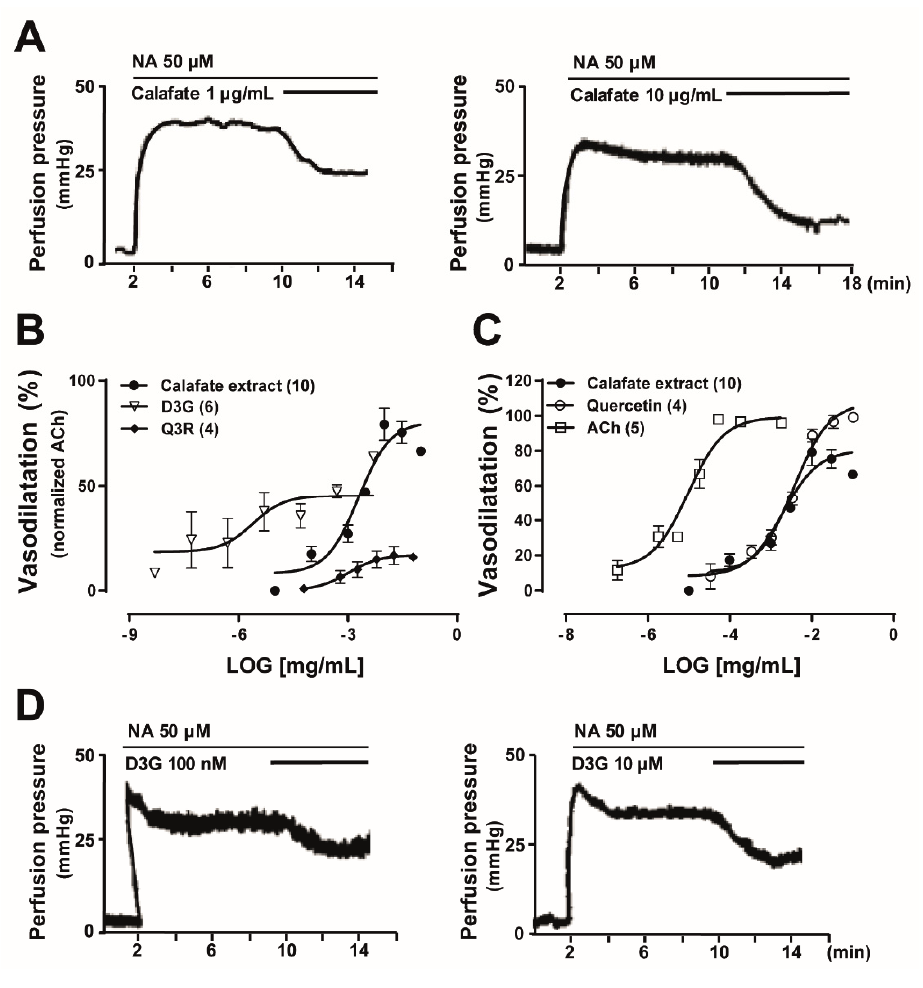
Figure 2. Concentration-dependent vasodilatation induced by Calafate berry extracts and the mimetic action of delphinidin-3-glucoside, quercetin, quercetin-3-rutinoside or acetylcholine in the rat arterial mesenteric bed. ( A ) Representative tracings of the hydroalcoholic extract-induced vasodilatation elicited by perfusion with 1 or 10 µg/mL; the extract was dissolved in distilled water and diluted in perfusion buffer. ( B ) The normalized 1 µM ACh concentration-dependent vasodilatation curves of the hydroalcoholic extract (solid circles) were compared to the main anthocyanin (delphinidin-3-glucoside, D3G open triangle) or flavonol (quercetin-3-rutinoside, Q3R solid diamond). ( C ) Comparison of the vasodilatation elicited by the Calafate extract, quercetin (open circles) or acetylcholine (ACh, open square). Symbols represent the mean values; bars the SEM. The number in parenthesis of panels B and C represents protocol replicates. ( D ) Representative tracings of the vasodilator response induced by 100 nM and 10 µM delphinidin-3-glucoside (D3G). All the experiments were made in intact mesenteric beds (with endothelium).